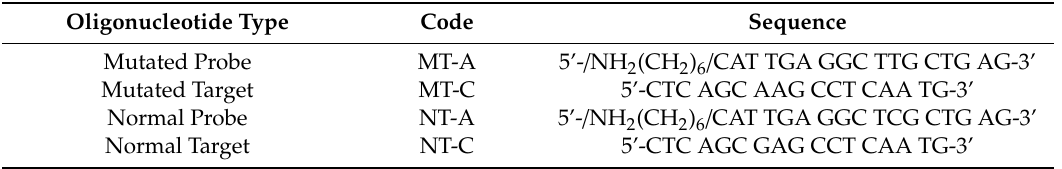
Table 1. Sequences of oligonucleotides used.